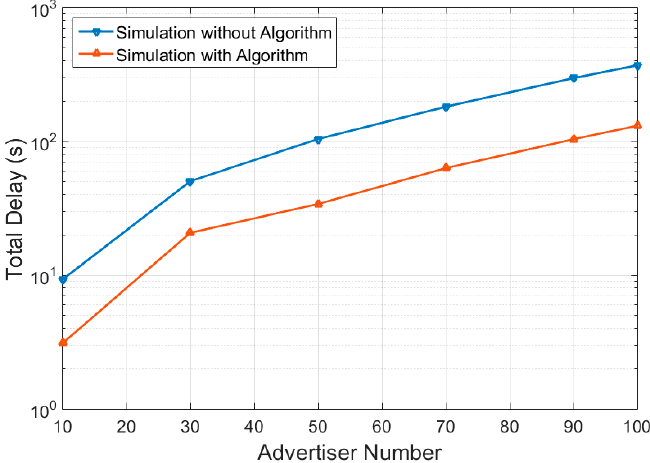
Figure 6. Total delay for advertiser discovery by the scanner.